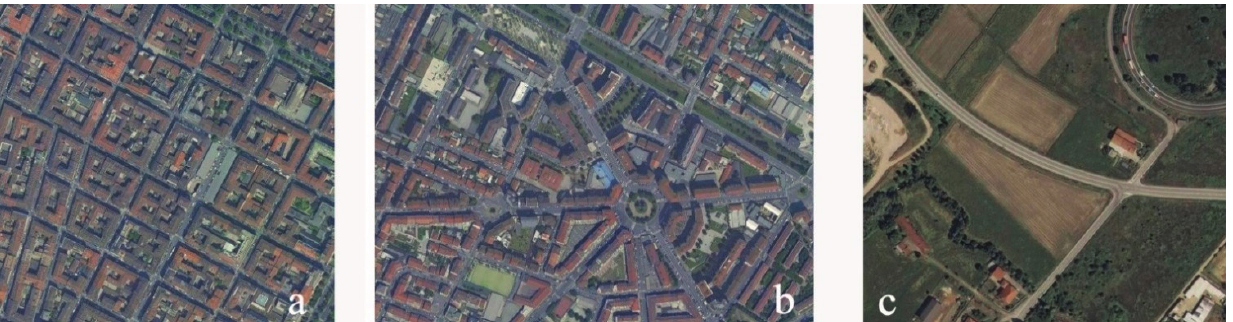
Figure 3. Examples of different urban densities within the city of Turin (( a ) Highest density = 3.96 m 3 /m 2 ; ( b ) Average density = 1.30 m 3 /m 2 ; ( c ) Lowest density = 0.02 m 3 /m 2